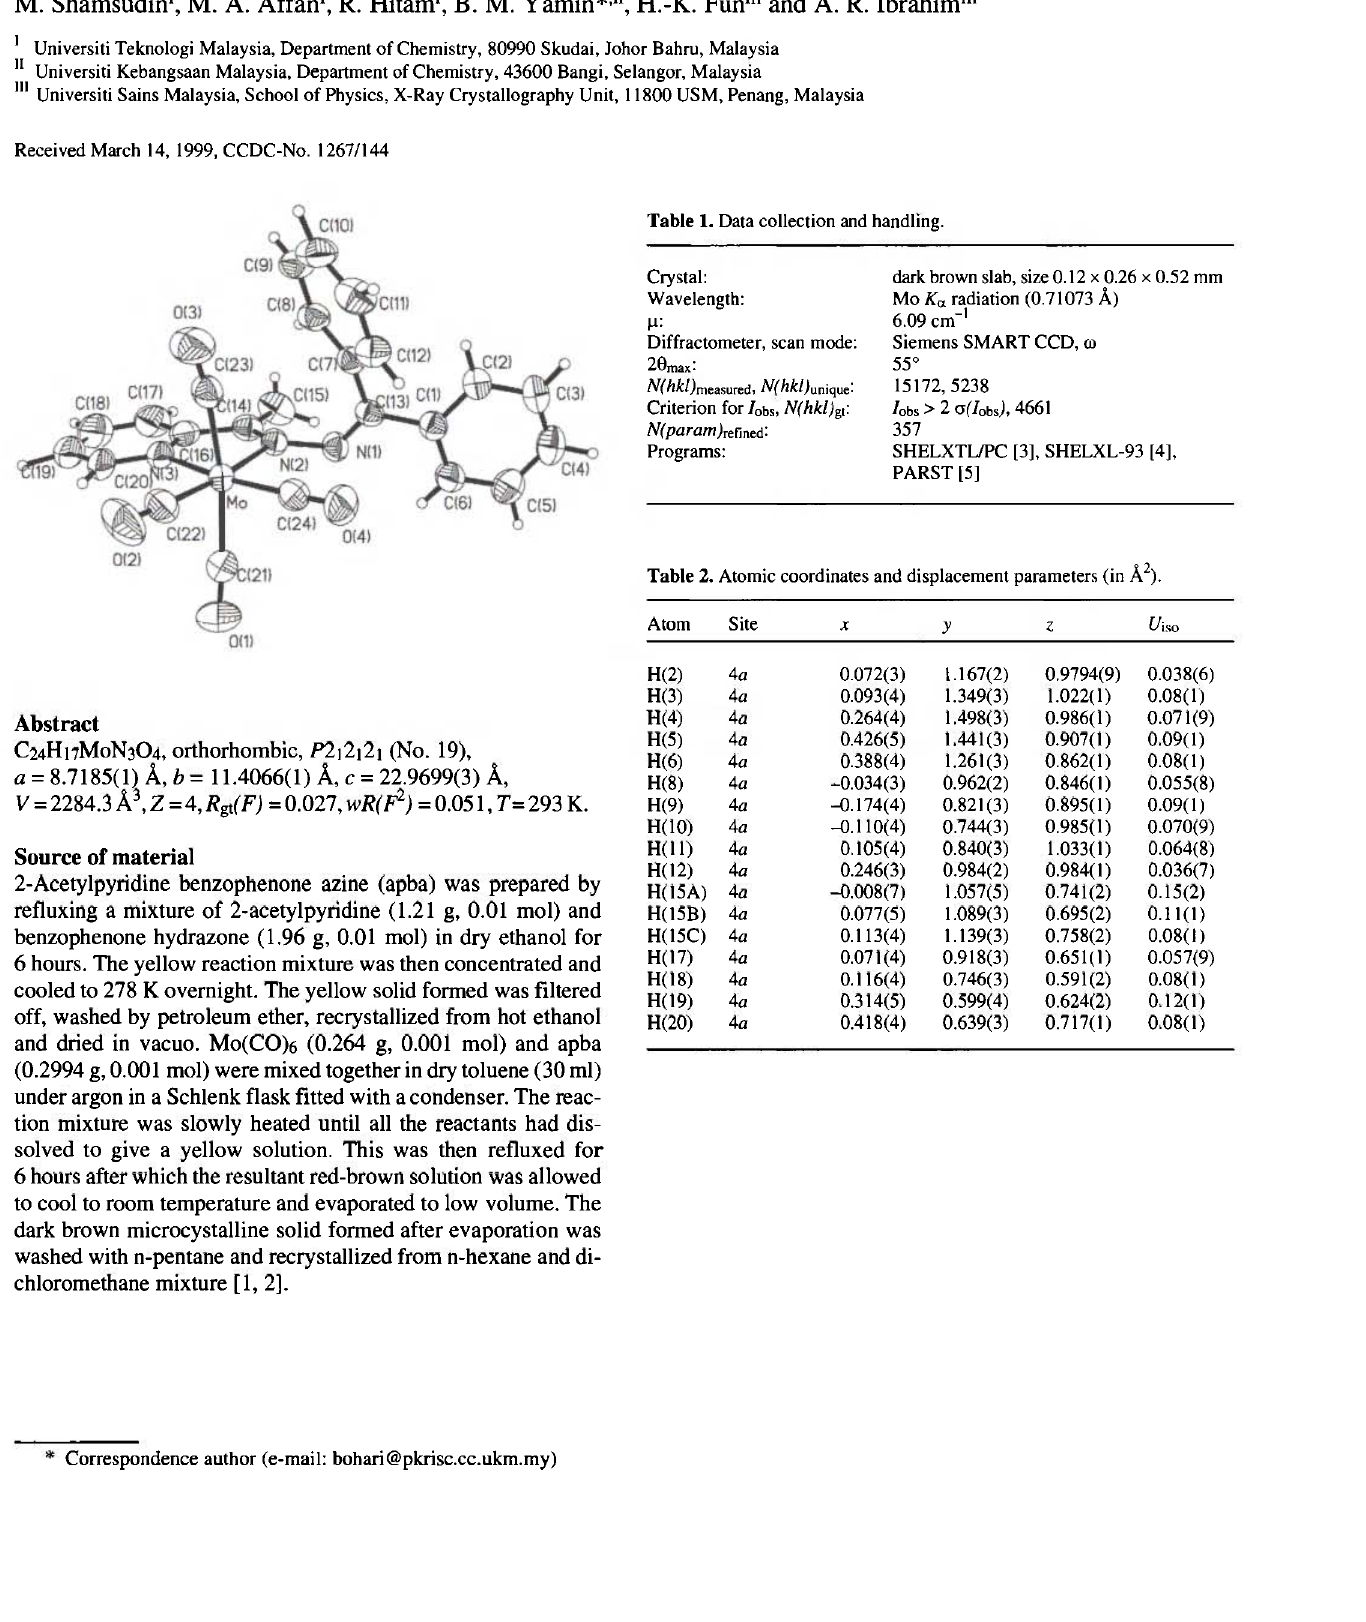
Table 1. Data collection and handling.